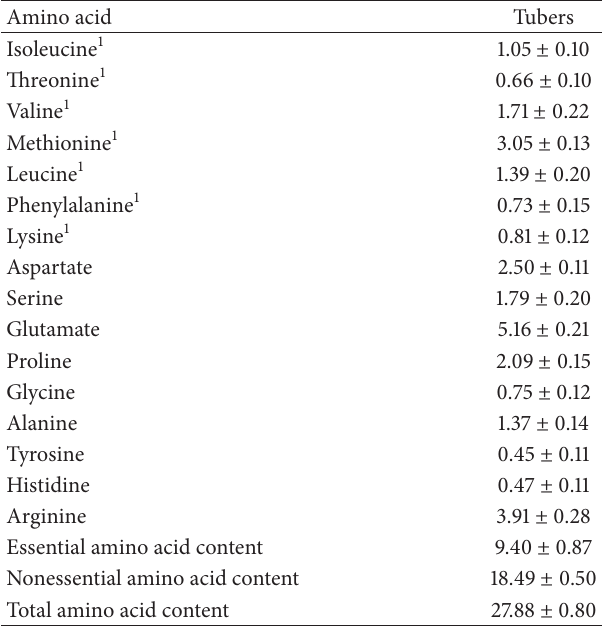
Table 3: Amino acid composition of O. japonicus tubers (mg/gDW).